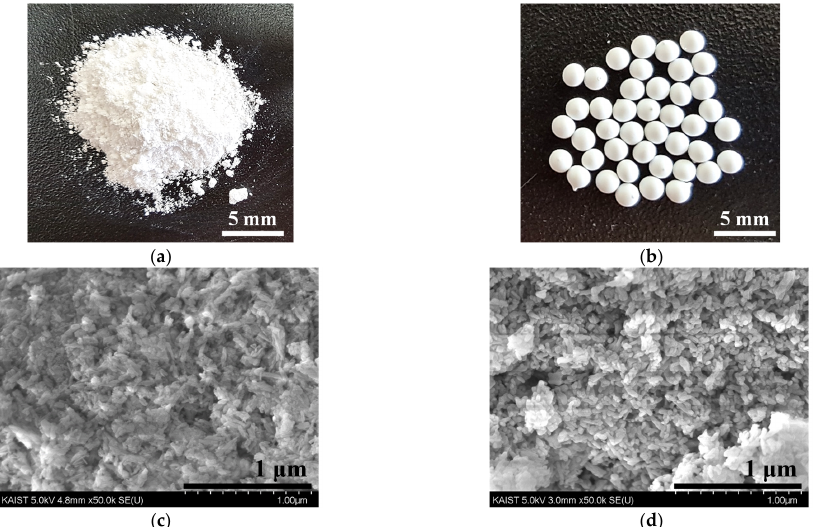
Figure 2. Microscopic and SEM images of p-HdA ( a , c ) and b-HdA ( b , d ).